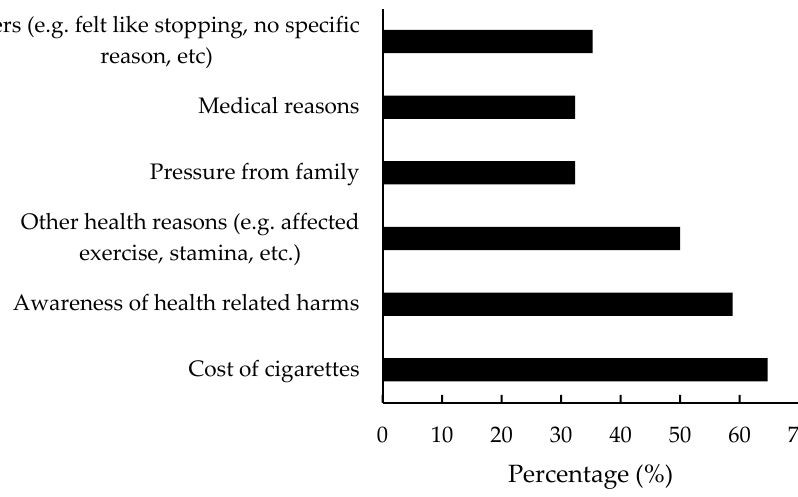
Figure 2. Factors that encouraged the past smokers to successfully quit smoking.